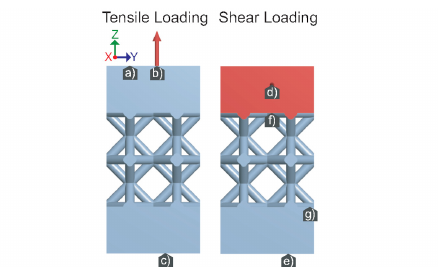
Figure 5. Tensile loading conditions: ( a ) Displacement allowed only in Z. ( b ) Applied force. ( c ) Fixed support. Shear loading conditions: ( d ) Applied force. ( e ) Fixed support. ( f , g ) Displacement allowed only in X and